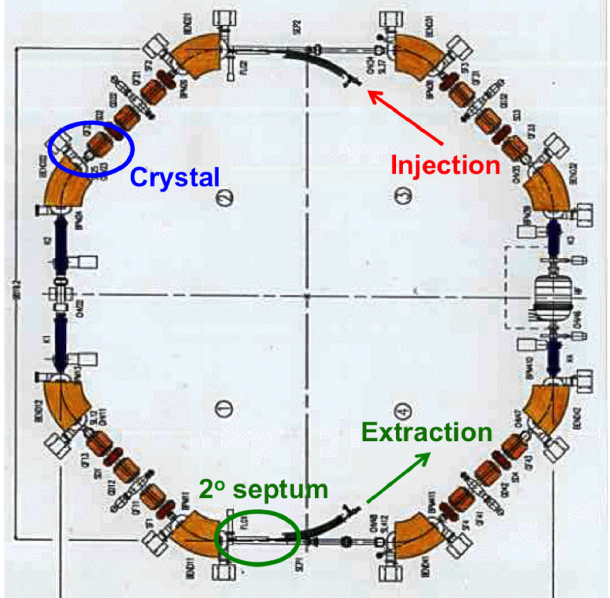
FIG. 2. Accumulator ring, location of the bent crystal and